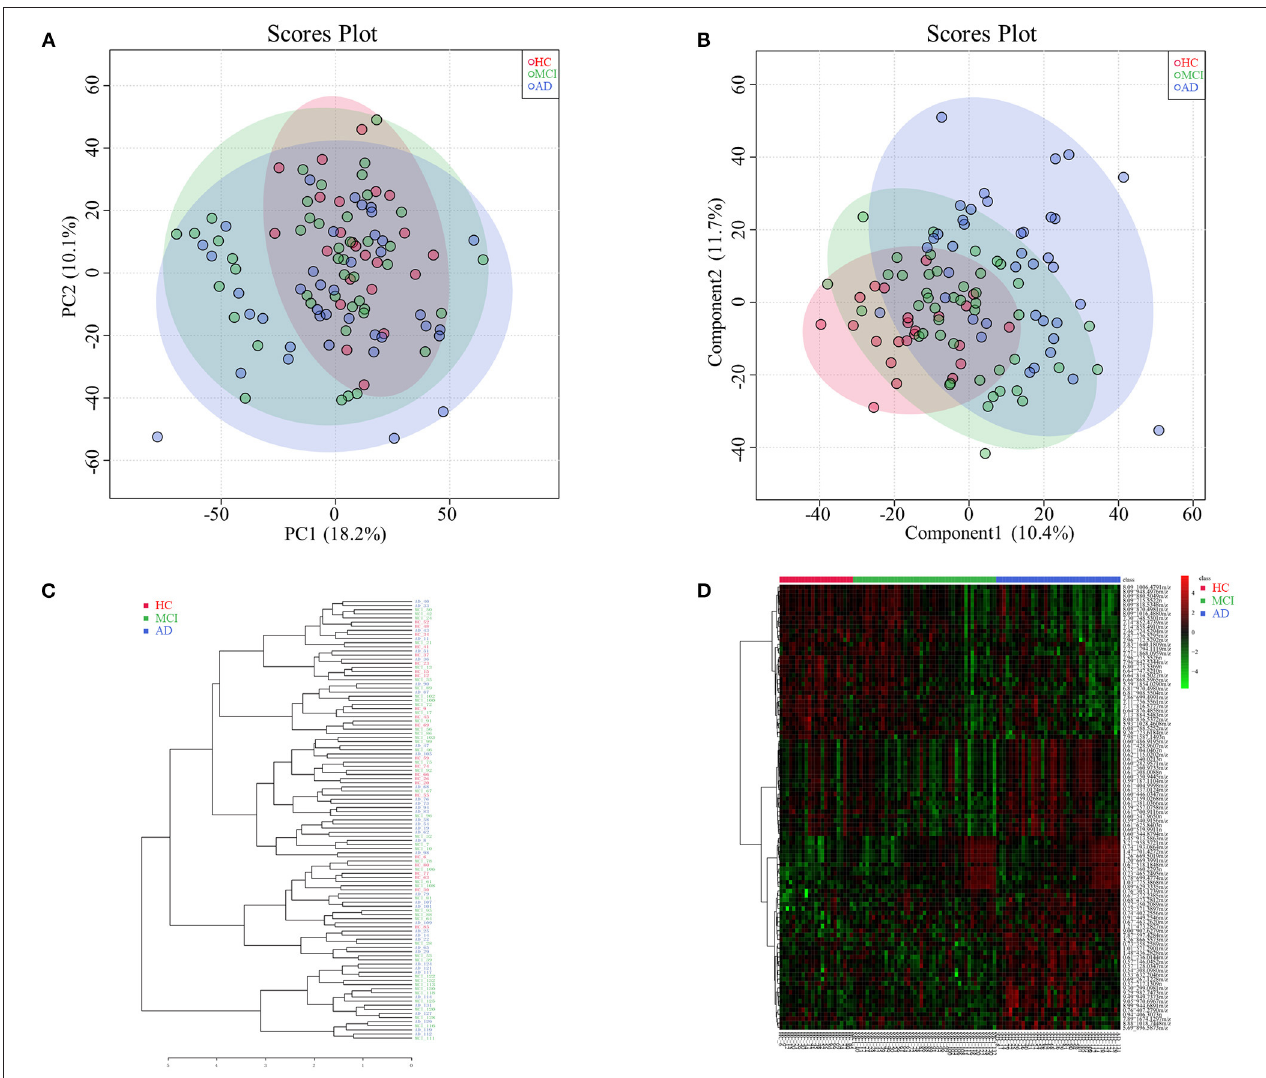
FIGURE 2 | (A) Principal component analysis diagram of HC, MCI and AD comparison. (B) Partial least squares-discriminant analysis diagram of HC, MCI and AD comparison. (C) Dendrogram construction of HC, MCI and AD comparison. (D) Heatmap results of HC, MCI and AD comparison.